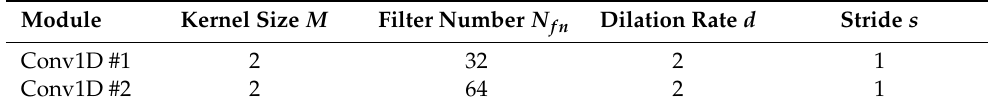
Table 1. Details for the 1D convolutions in the two convolution modules. In the table, “Conv1D #1” means the first 1d convolution module, and “Conv1D #2” the second. Module Kernel Size M Filter Number N